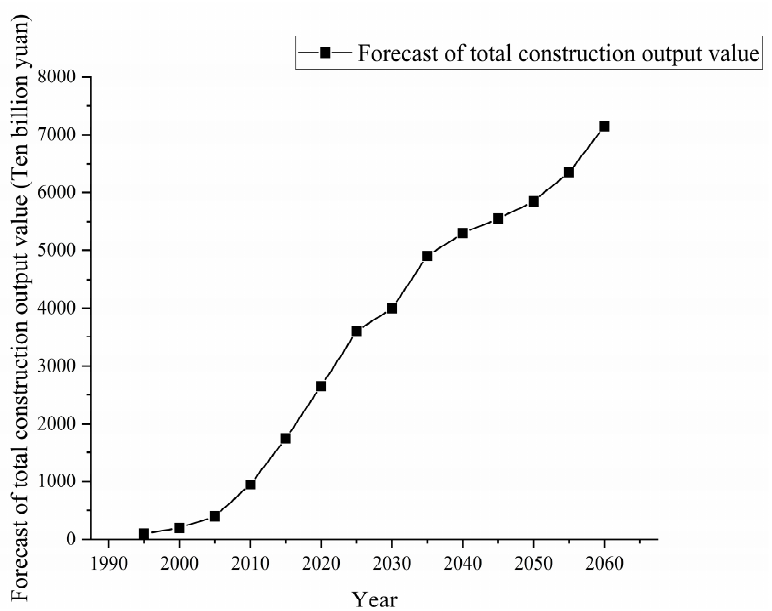
Figure 7. Forecast of total construction output value (10 billion yuan).